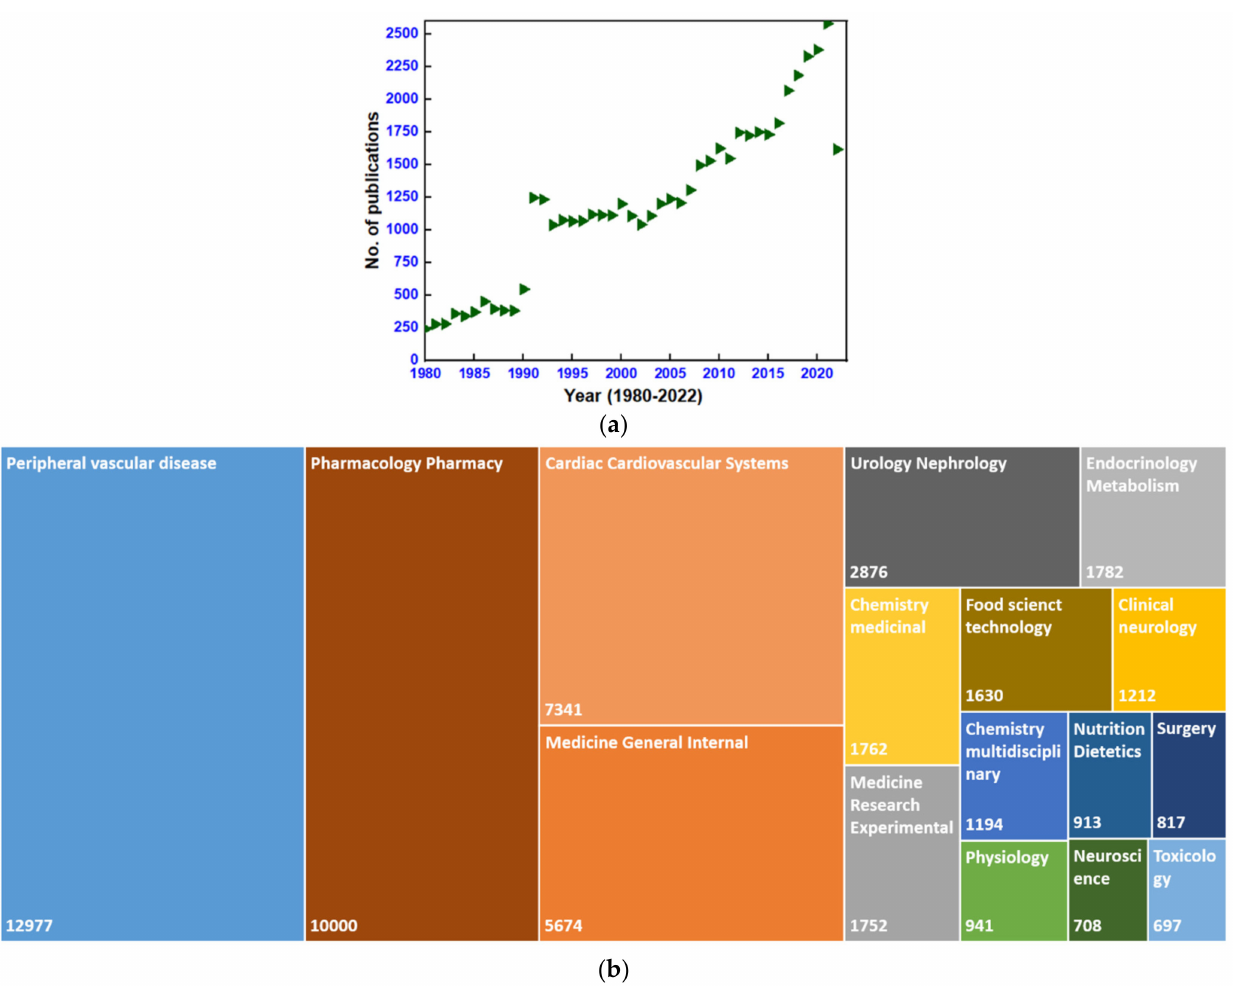
Figure 1. ( a ) Point graph presenting yearly publications and ( b ) a tree graph presenting publications in different areas of research (Web of Science search data obtained on 22 October 2022 using keywords dihydropyrimidines or calcium channel blockers, from January 1980 to October